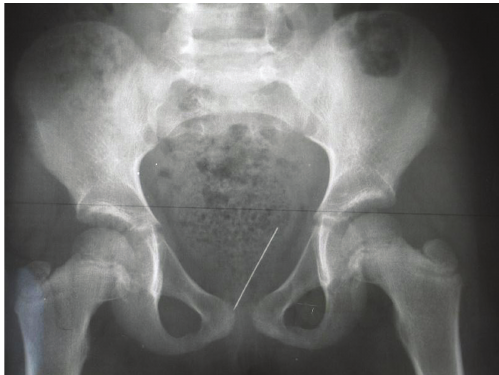
Figure 3: Posteroanterior pelvic radiogram of case 2 showed that there is a linear radio-opaque shadow in the region of bulbar urethra. In this graph the foreign body seems about 3 to 4cm because of its direction.